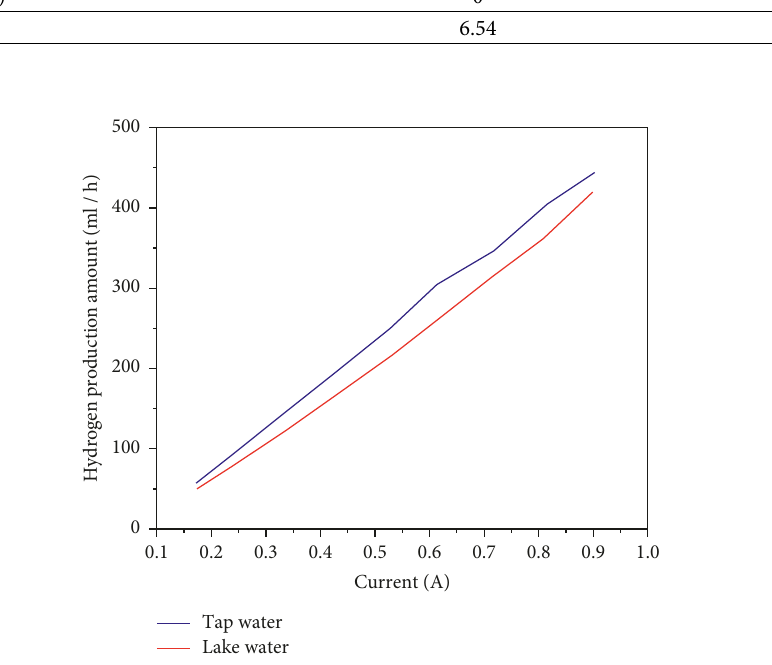
Figure 7: Effect of magnetic field on microstructure of 3.5% NaC1 solution g Table 1: Ion hydration number of salt ion pairs in solution. Magnetic field intensity (T) Ion hydration number